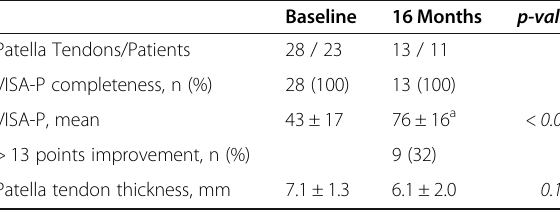
Table 2 VISA-P and Patella tendon thickness